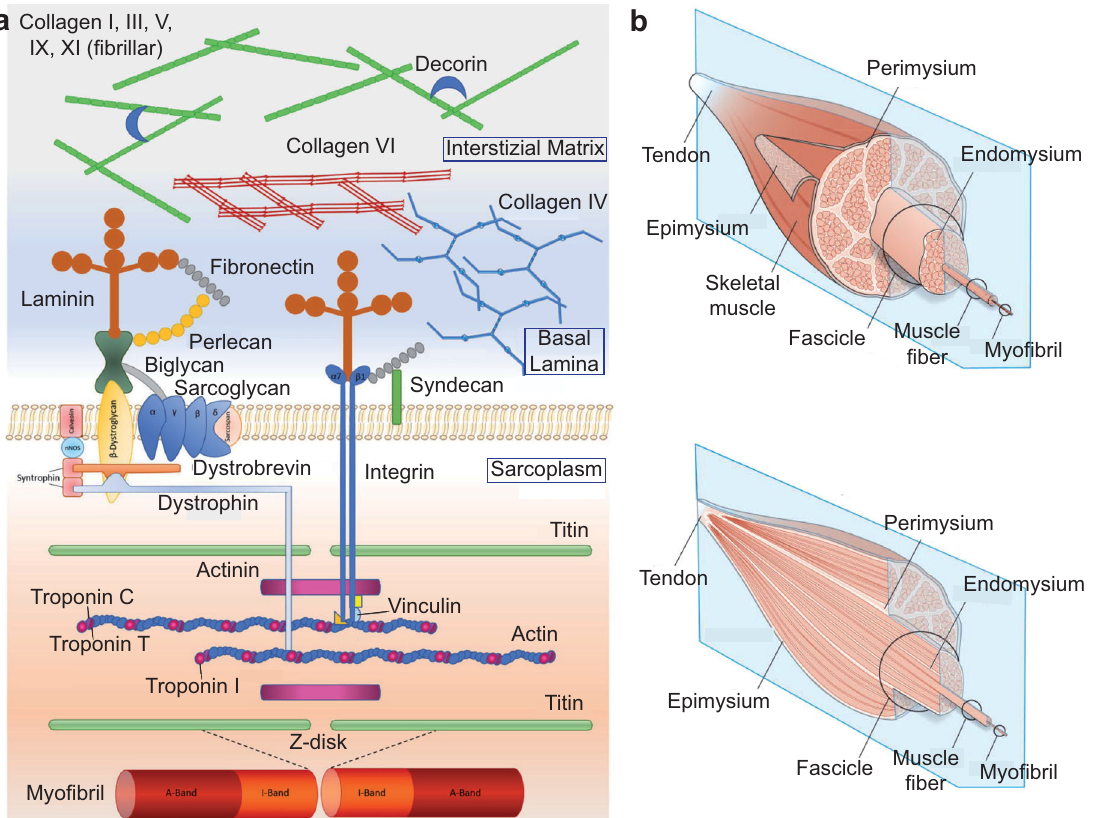
Fig. 2 Skeletal muscle microenvironment and architecture. a The skeletal muscle cell contractile unit (the sarcomere, at the bottom) and its interface with the extracellular matrix. Image reproduced and adapted with permission from 43 . b Organization of the muscle tissue and the intramuscular connective tissue. Image reproduced and adapted with permission from 42